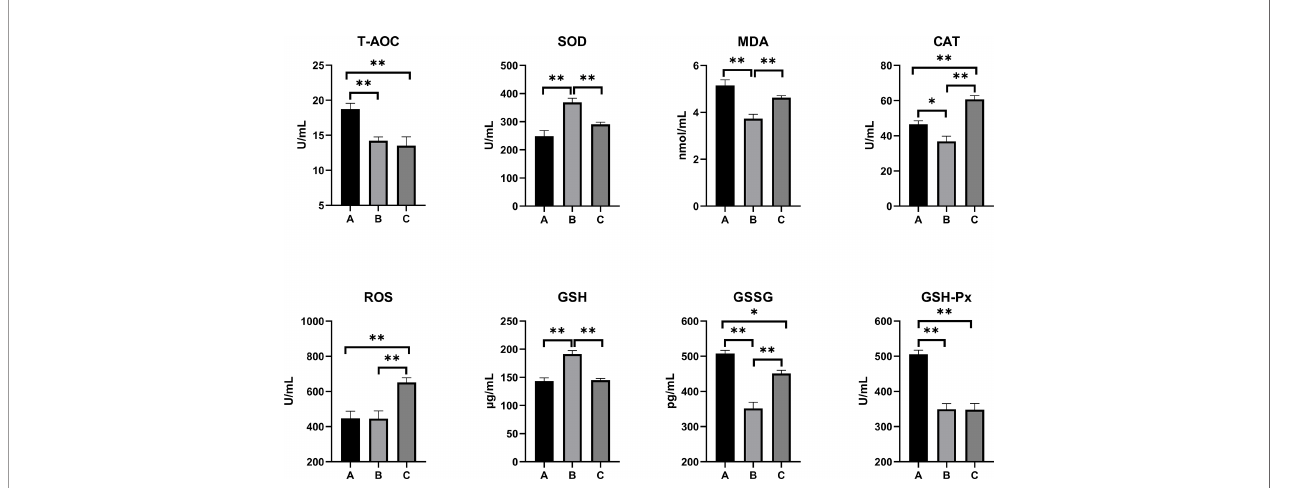
FIGURE 2 | Effects of OTA and AFB1 on serum oxidative stress and antioxidant status of pullets after 42 days (n = 6, mean ± SEM), including T-AOC, SOD, MDA, CAT, ROS, GSH, GSSG, and GSH-Px. Groups A, B, and C are the control group, the pair-feeding group, and the OTA+AFB1 group, respectively. Data were analyzed with ANOVA and Tukey ’ s HSD, and signi fi cant differences were de fi ned as * p < 0.05, and ** p < 0.01. OTA, ochratoxin A; AFB1, a fl atoxin B1; T-AOC, total antioxidant capacity; SOD, superoxide dismutase; MDA, malondialdehyde; CAT, catalase; ROS, reactive oxygen species; GSH, glutathione; GSSG, oxidized glutathione; GSH-Px, glutathione peroxidase; HSD, honestly signi fi cant